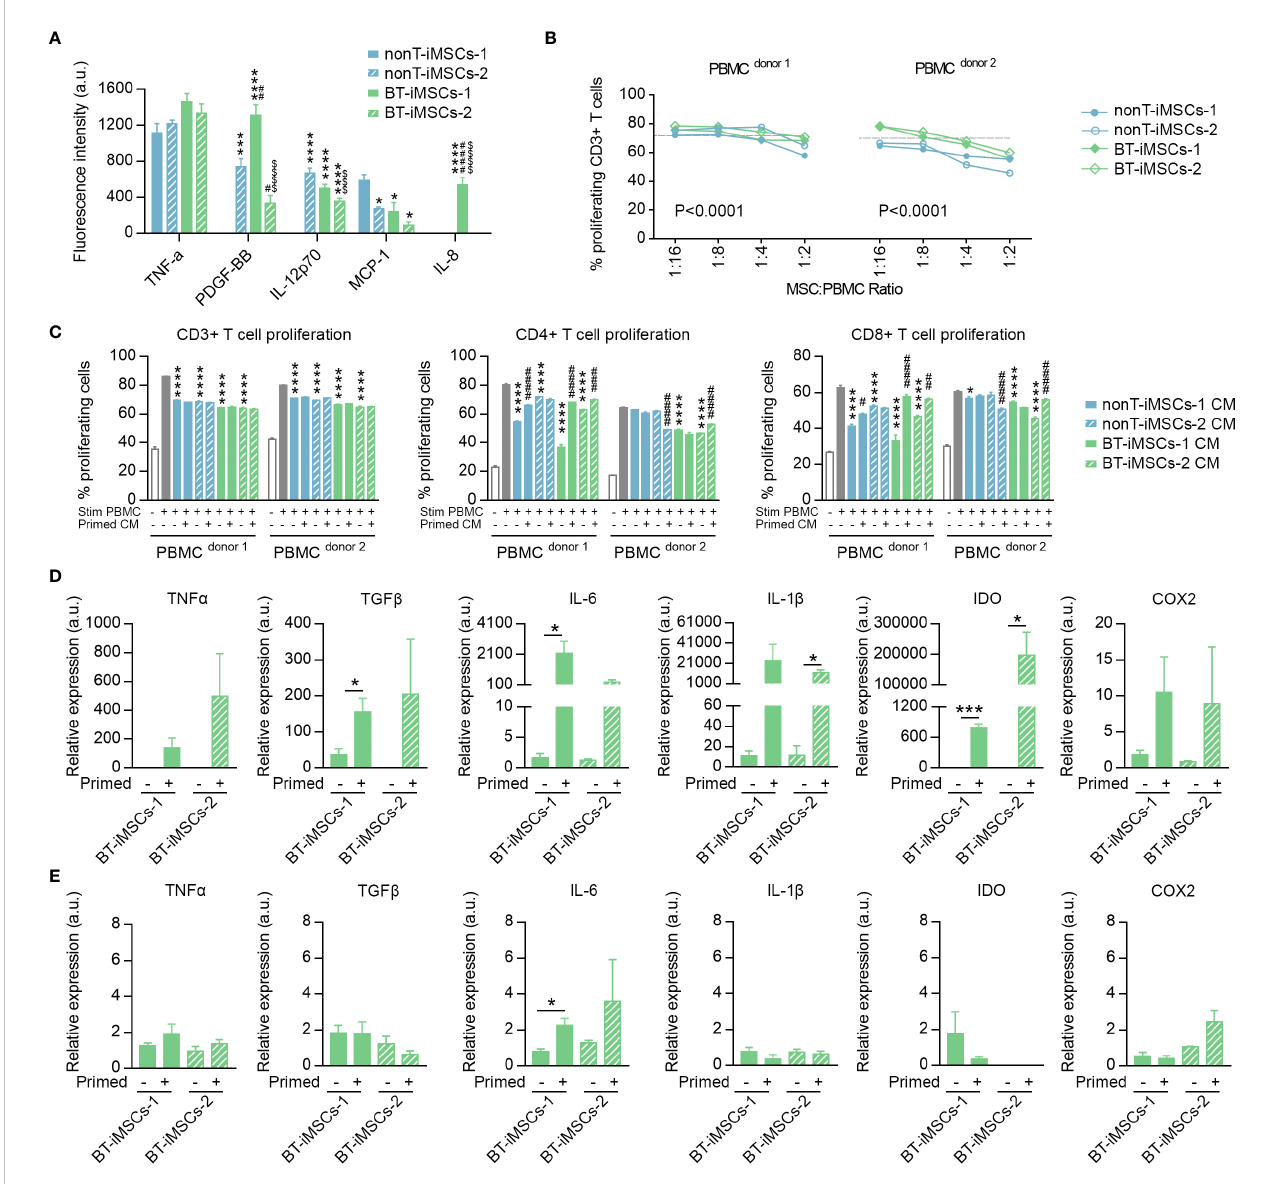
FIGURE 7 Immunomodulatory potential of the generated iMSCs. (A) Bar graph showing the fl uorescence intensity for in fl ammatory cytokines secreted by iMSCs determined by ELISA. (B) Inhibitory effect of iMSCs on CD3+ T cell proliferation after 5 days co-culture. Dashed line indicates the % of proliferation for CD3+ T cells without iMSCs. (C) Bar graphs showing the percentage of CD3 + , CD4 + and CD8 + proliferating T cells in response to the secretome of primed or non-primed iMSCs. Of note, the secretome was collected 48 hours after priming. (D) Bar graphs showing the expression levels of immunomodulatory genes analyzed by RT-qPCR in primed and non-primed iMSCs derived from BT patients. Of note, the RNA was isolated immediately after priming. (E) Bar graphs showing the expression levels of immunomodulatory genes analyzed by RT-qPCR in primed and non-primed iMSCs derived from BT patients. Of note, the RNA was isolated 48 hours after priming. Data are represented as mean ± SEM. The absence of bar in any graph indicates undetected levels of the speci fi c parameters assessed. For (A) ; *p*0.05, ***p<0.001, ****p<0.0001 compared to nonT-iMSCs-2; # p<0.05, ## p<0.01, #### p<0.0001 compared to nonT-iMSCs-1; $$$p<0.001, $$$$p<0.0001 compared to BT-iMSCs-1. One-way ANOVA. For (B) ; P value refers to dose effects. Two-way ANOVA. For (C) ; *p<0.05, ****p<0.0001 compared to stimulated PBMC cultured in regular growth medium. # p<0.05, ##